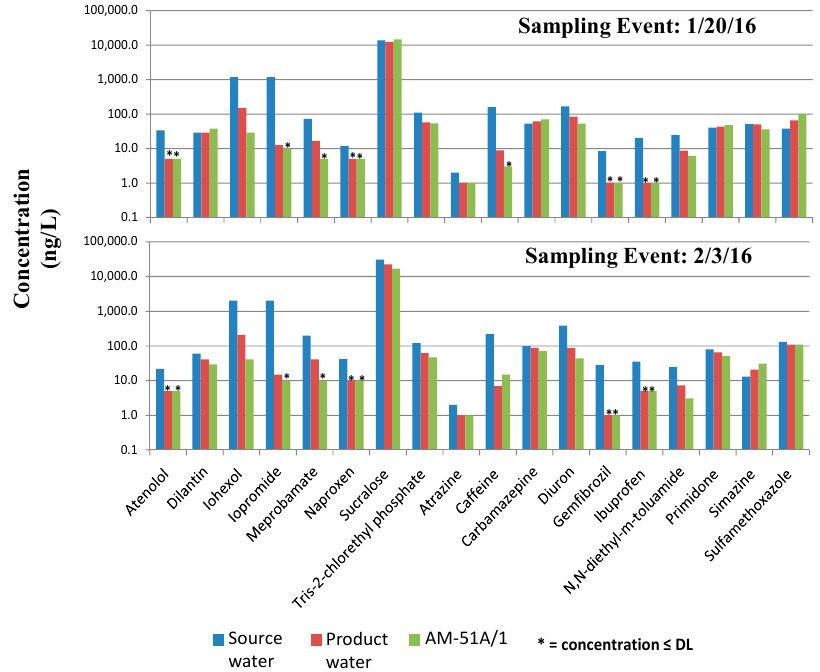
Figure 6. CECs Detected in Source Water, RFS Product Water and in Groundwater (AM-51A) Downgradient of Olive Basin for January and February 2016 Sampling Event. (Note: For compounds detected in source water but not in product water, the detection limit value is shown and denoted with * . Additional compounds were analyzed but were below the detection limit in the source water.)